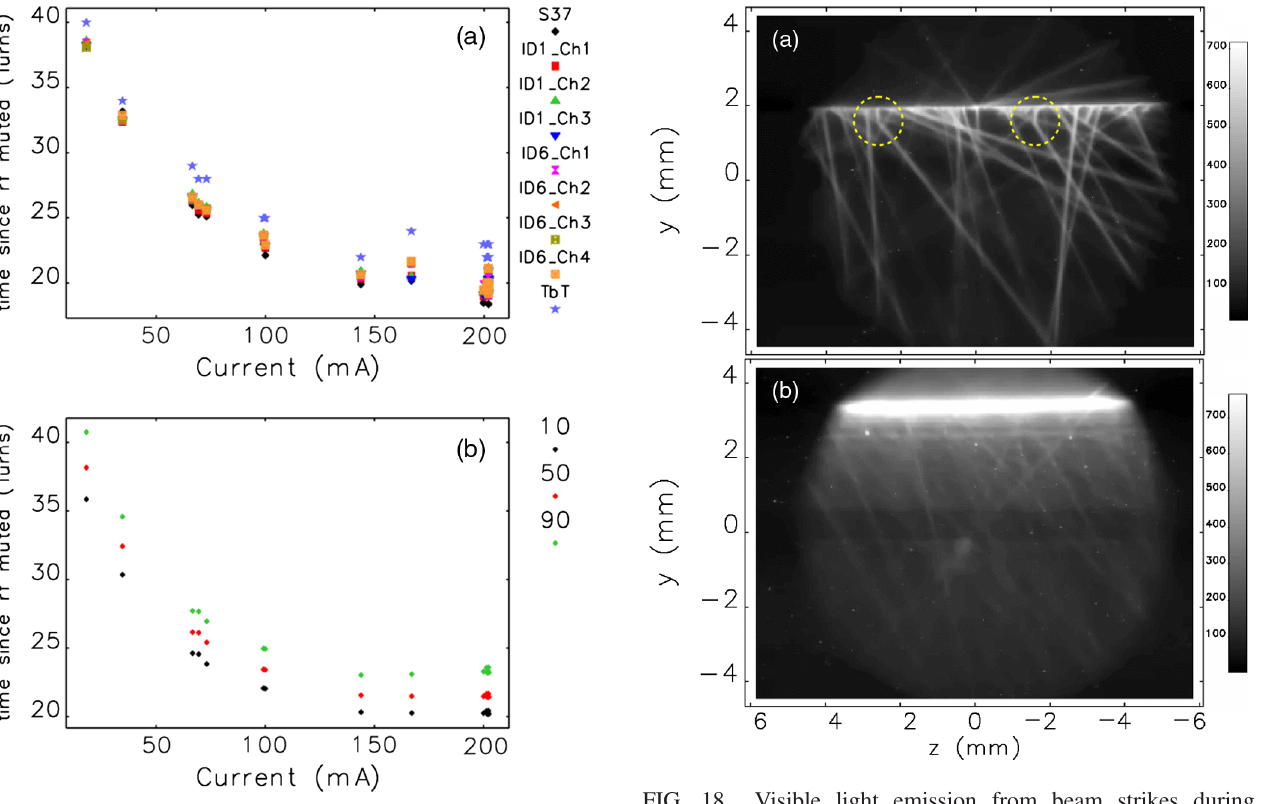
FIG. 17. Comparison of loss signal arrival times determined from (a) the fast BLMs and TBT BPMs and (b) PELEGANT simulations. The fast BLMs are based on high-purity, fused-silica fiber optic bundles; in sector 1 these are labeled ID1_ChM, where M ¼ 1 ; 2 ; 3 and in sector 6 labeled ID6_ChN, where N ¼ 1 ; 2 ; 3 ; 4 . PELEGANT results are presented for 10, 50, and 90 percent particle loss.